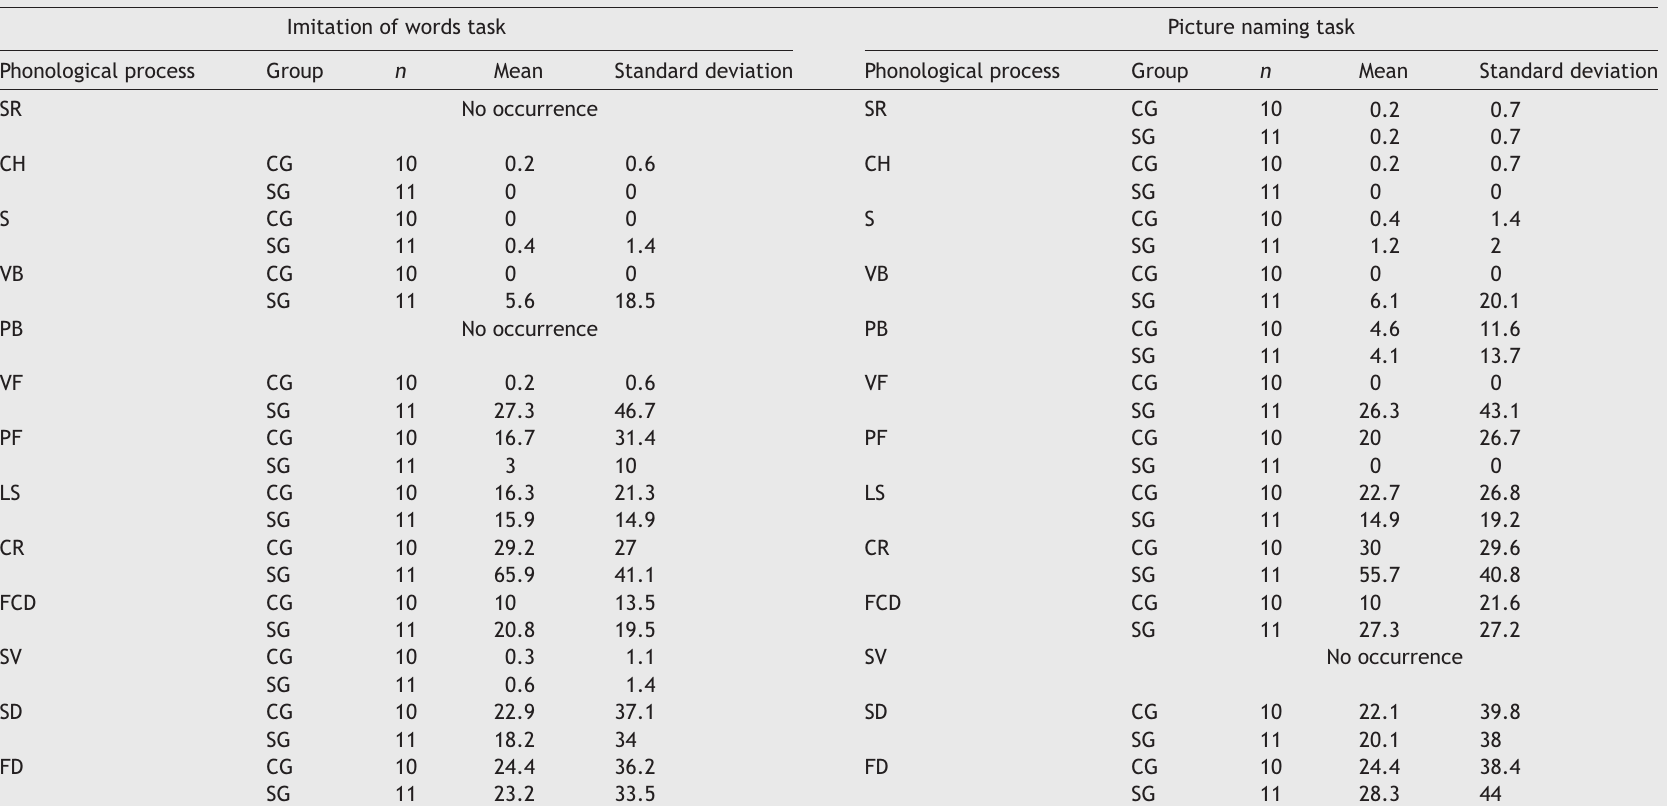
Descriptive values for percentage of occurrence of phonological processes in phonology tasks in the control group (CG) and study group